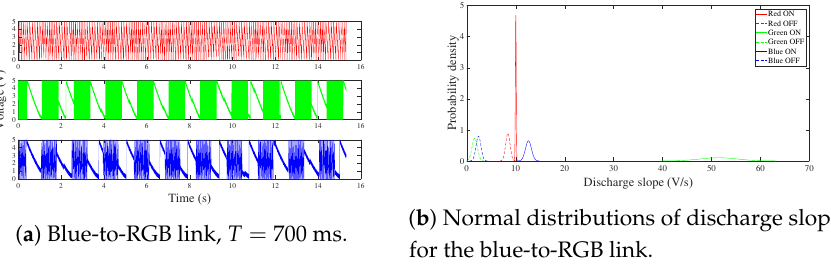
Figure 15. Blue LED to RGB LED, T = 700 ms: transmitting with a blue LED and sampling the three RGB